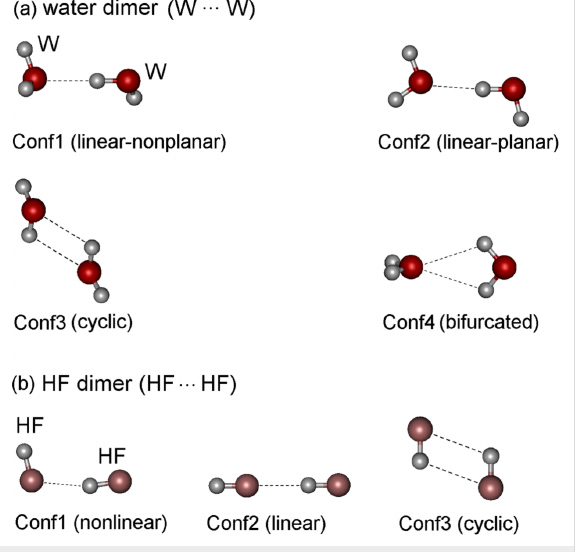
Figure 1: The conformers of (a) water dimer and (b) HF